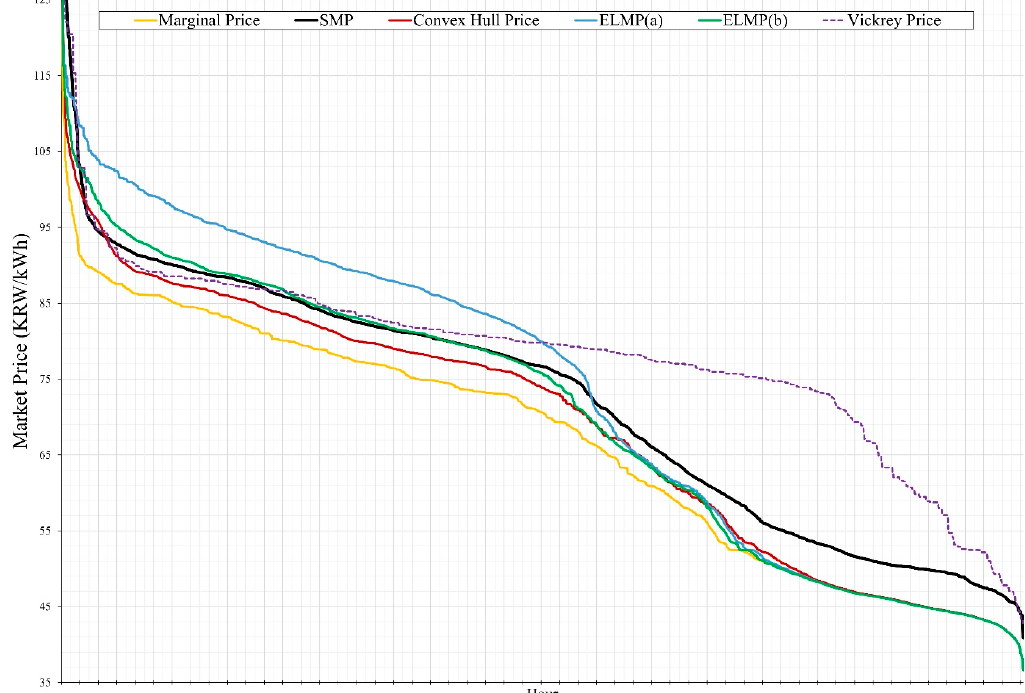
Figure 6. Price duration curves by market price for 2017.